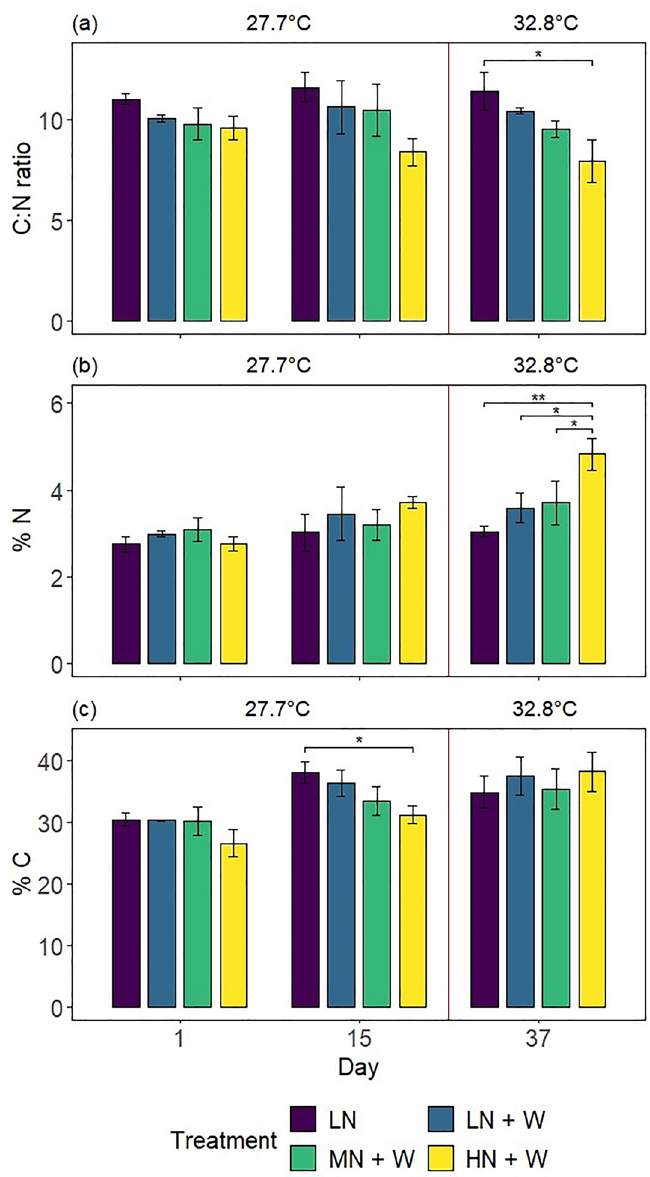
Figure 5. ( a ) Carbon to nitrogen ratio, ( b ) percent nitrogen and ( c ) percent carbon per dry weight of Xenia umbellata colonies from control tanks with low nitrate (LN, ~ 0.6 μM) and three treatments: LN + W = low nitrate (~ 0.6 μM) + warming from day 17; MN + W = medium nitrate eutrophication (~ 6 μM) + warming from day 17; HN + W = high nitrate eutrophication (~ 37 μM) + warming from day 17. Error bars represent standard deviations of three replicates, with exceptions of two replicates for controls (LN) on day 15 ( a & c ) and the LN + W treatment on day 37 ( a , b & c ). Temperatures represent mean temperatures of the respective days, excluding controls (LN). Asterisks indicate significant differences between treatments within days (pwc, Bonferroni adjustment, t -test, ** = p < 0.005, * = p <